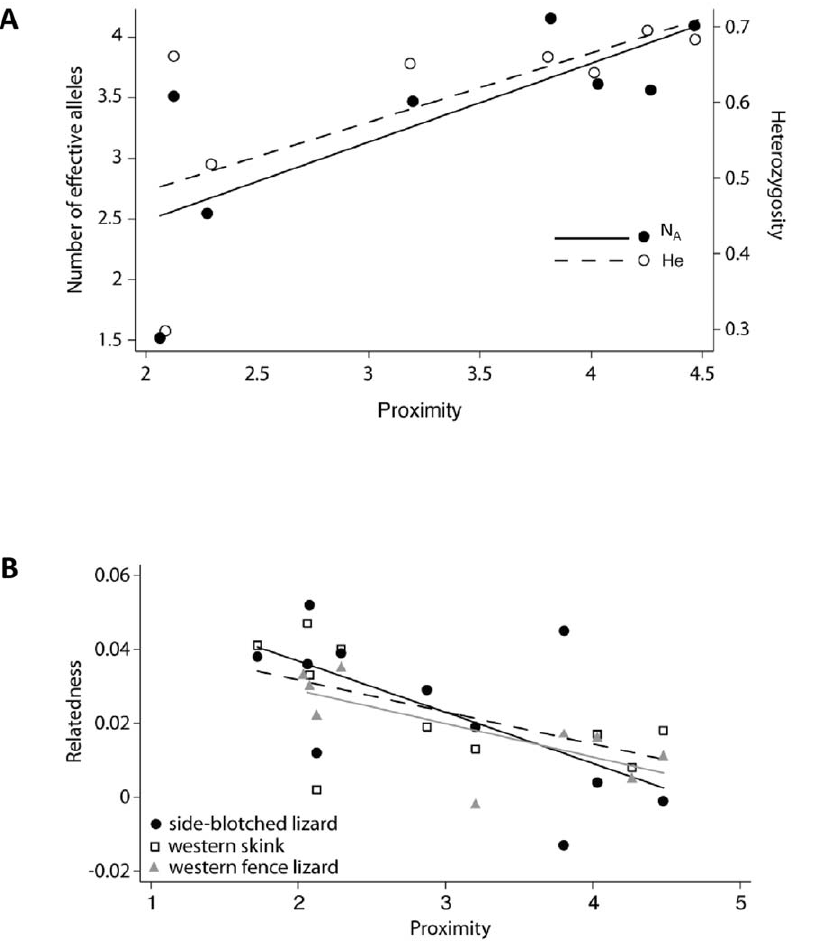
Figure 3. Relationship between genetic diversity (heterozygosity, number of effective alleles, and relatedness) and patch proximity a (log transformed). A. wrentits (H e : R 2 =0.698, p=0.051, d.f.=7; N A : R 2 =0.55, p=0.035, d.f.=7) and B. three lizard species (R LR : side- blotched lizard R 2 =0.4, p=0.03, d.f.=10; western skink R 2 =0.33, p=0.05, d.f.=9; western fence lizard R 2 =0.52, p=0.002, d.f.=8). a Patch proximity is the inverse of patch